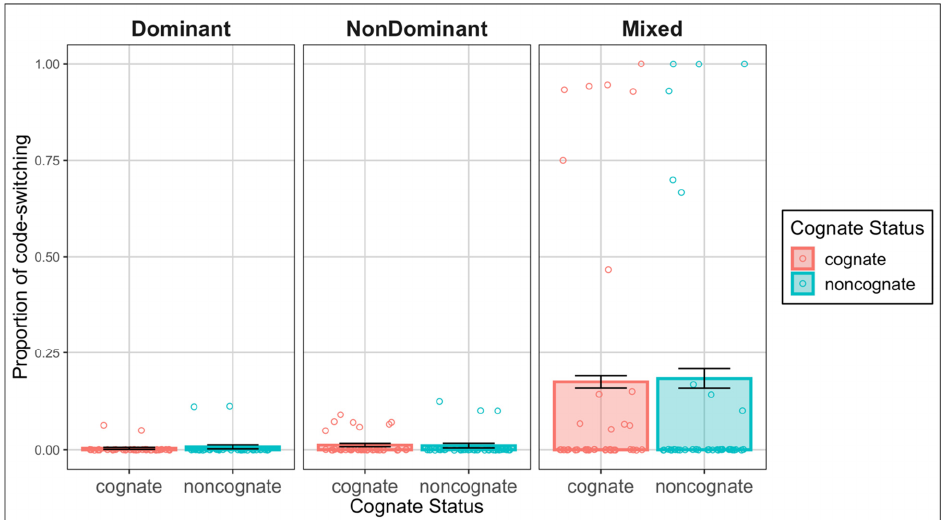
Figure 1. Average proportion of code-switching by condition and cognate status with standard error bars. Data points are aggregated by participant.